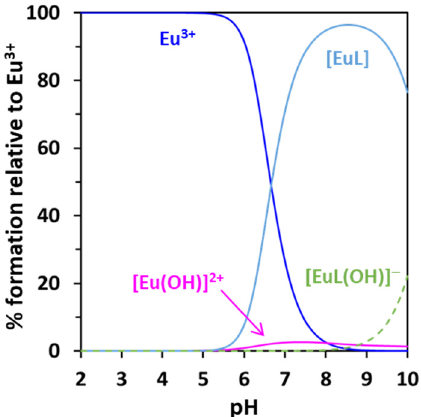
Figure 8. Distribution diagram of the Eu p L q H r species as a function of pH in the Eu 3+ /CFA system ( c CFA = c Eu3+ = 1 mmol · dm − 3 ), drawn using the determined UV-Vis set of constants. Dash line is used for the species detected only on UV-Vis spectrophotometric measurements.